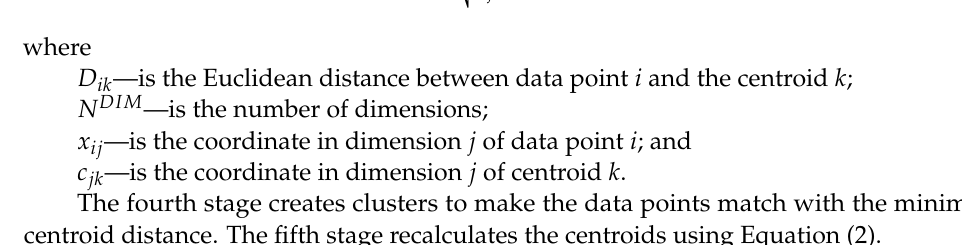
Figure 3. An example of preprocessed